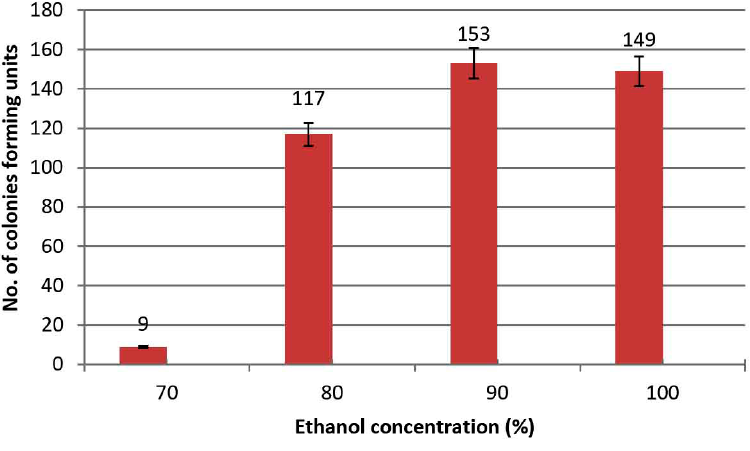
LSD(P ≤ 0.05)=50.037 Fig. 3. Number of colonies forming units (CFU) on agar plate resulted from growth of B. thuringiensis spores after spreads 0.1 ml of spore suspension from surgical tools treated with Ethanol